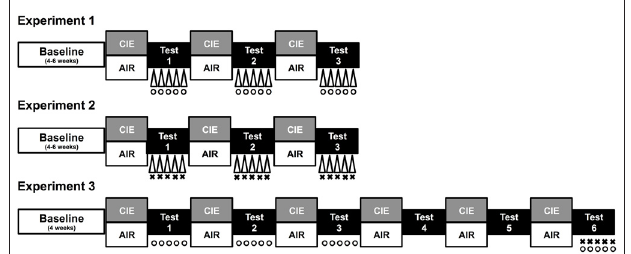
FIGURE 1 | Procedure overview. Each study consisted of a period of baseline ethanol consumption followed by repeated 1-week cycles of CIE